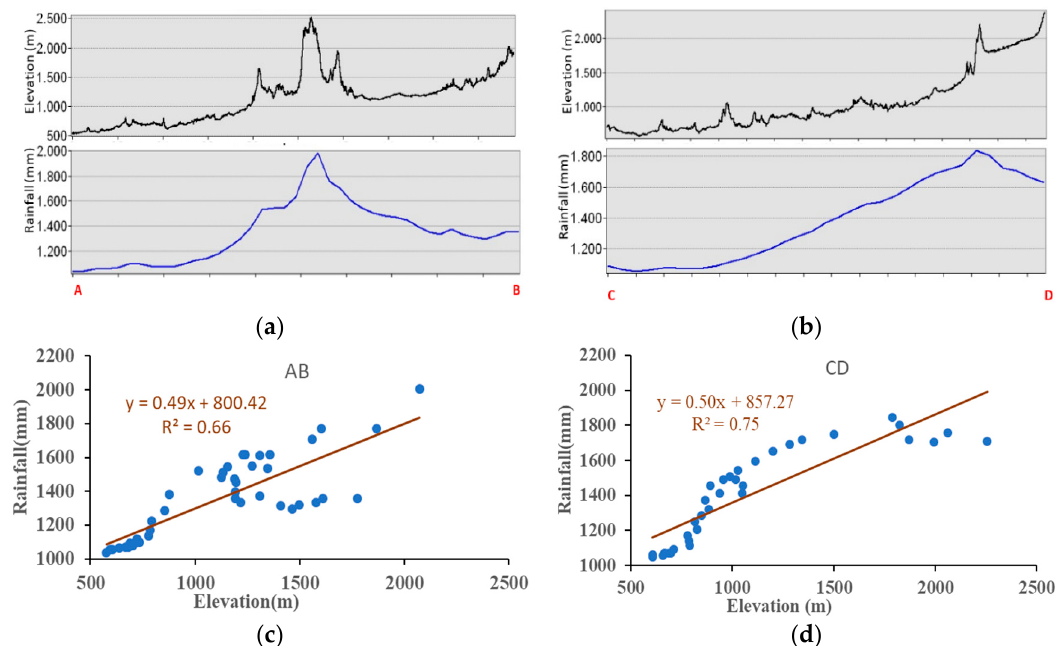
Figure 6. Long-term mean monthly rainfall and elevation along transect line (Figure 5) from A to B ( a , c ) and from C to D ( b , d ) and a scatter plot ( c , d ) of regression equation to determine rate of change of rainfall with elevation for each transect line AB and CD.